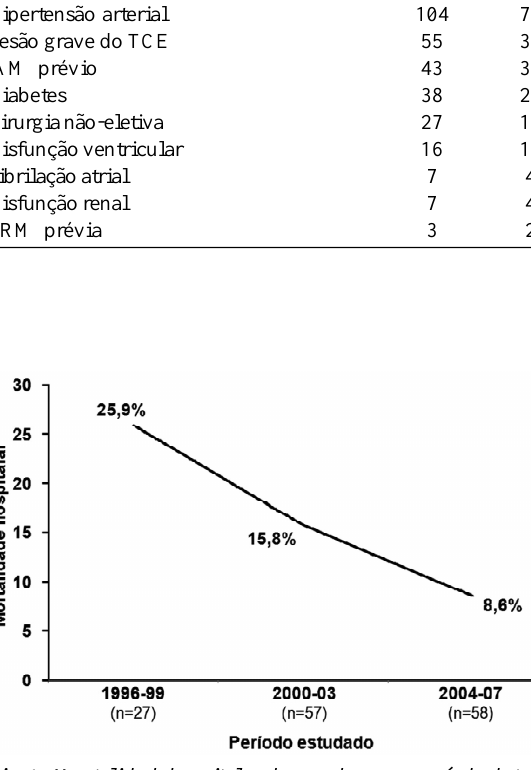
Fig. 1 - Mortalidade hospitalar de acordo com o período de tempo estudado